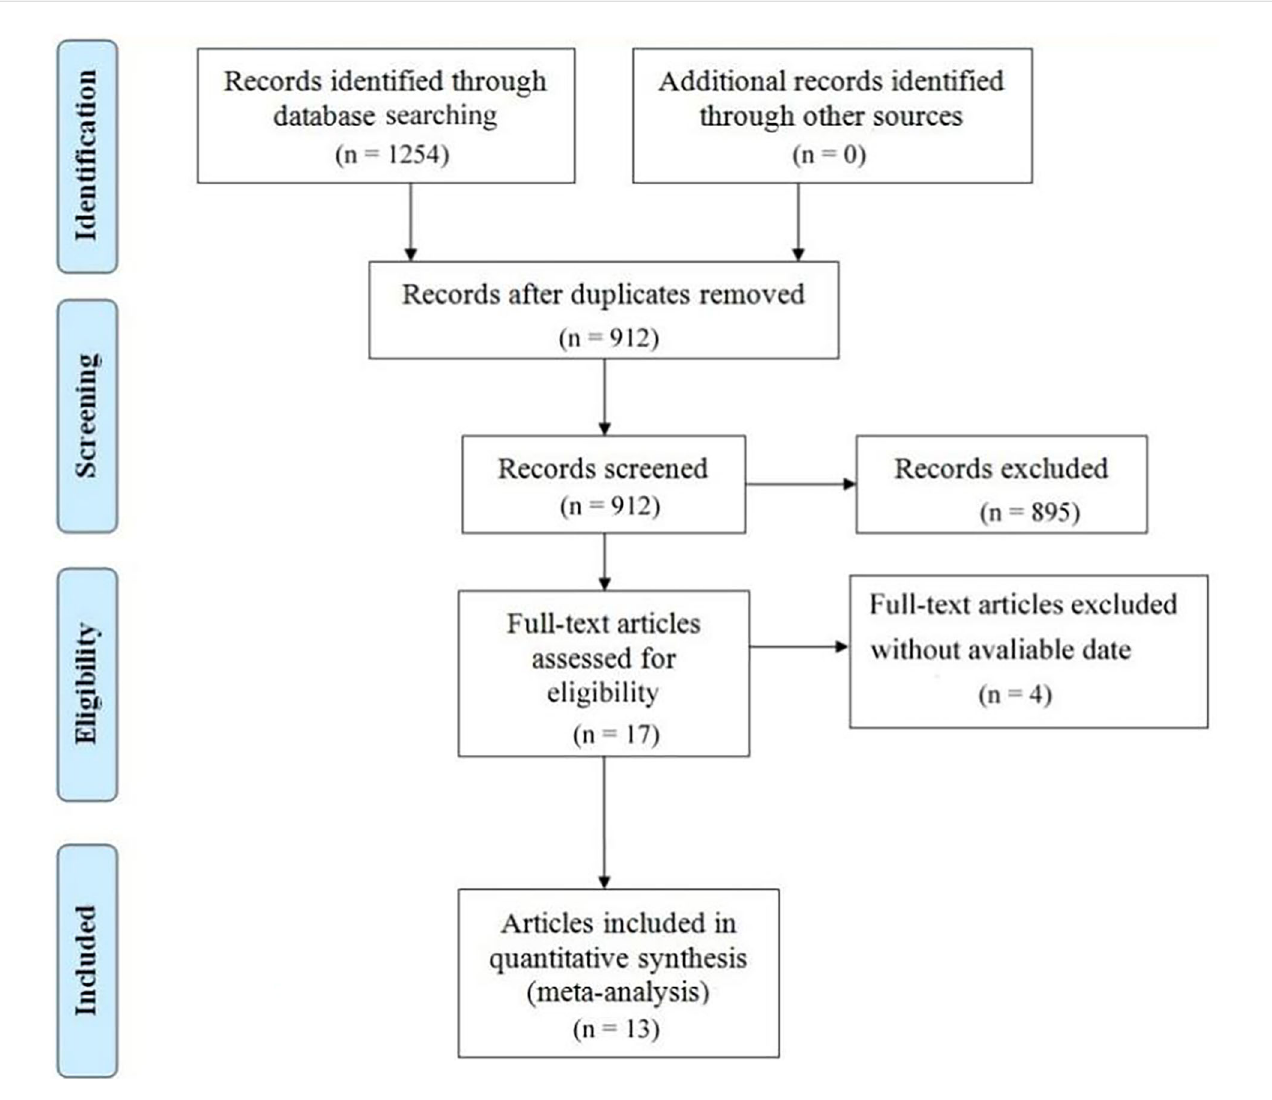
FIGURE 1 Study fl ow